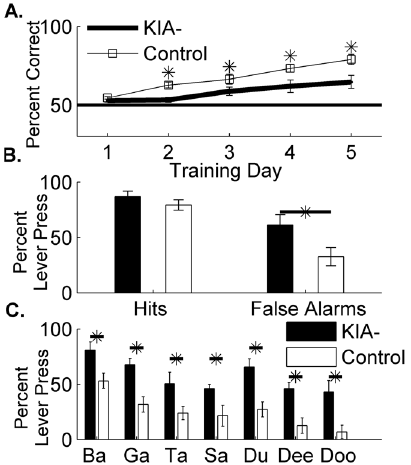
Figure 1. Rats with inutero RNAi of Kiaa0319 are impaired at speech discrimination tasks. A . Performance of KIA- and control rats on the first 5 days of full length speech training. KIA- rats were significantly worse than control rats on the full speech discrimination task on 4 of the days (*=p , 0.01). B . On day 5 of testing, KIA- rats hit to the target sound dad at the same rate as control rats (unpaired t-test; p=0.33), but false alarmed to the distractor sounds significantly more than control rats (*=p=0.04). C . Break down of lever press rates on day 5 of testing to each of the distractor sounds. KIA- rats responded to every sound significantly more than control rats (unpaired t-tests, *=p , 0.01).